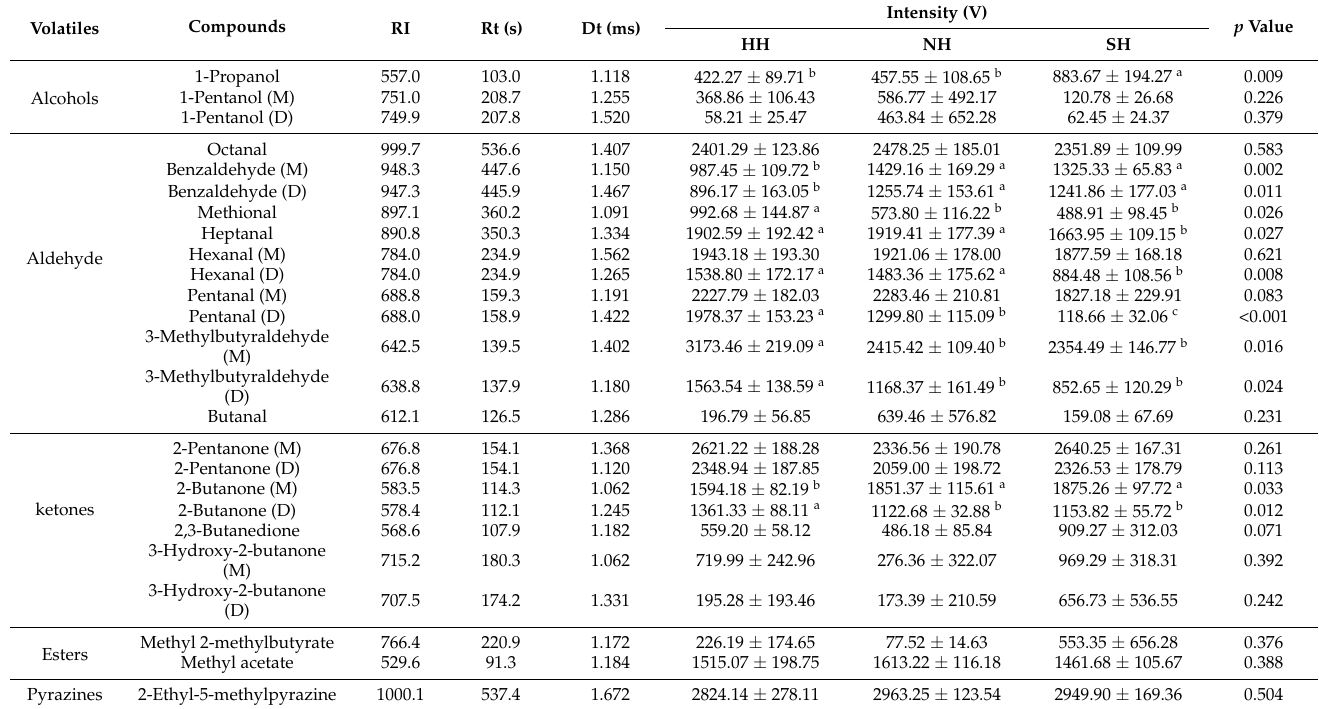
Table 2. Volatile flavor compounds tested in F 1 crossbred lambs using GC–IMS.